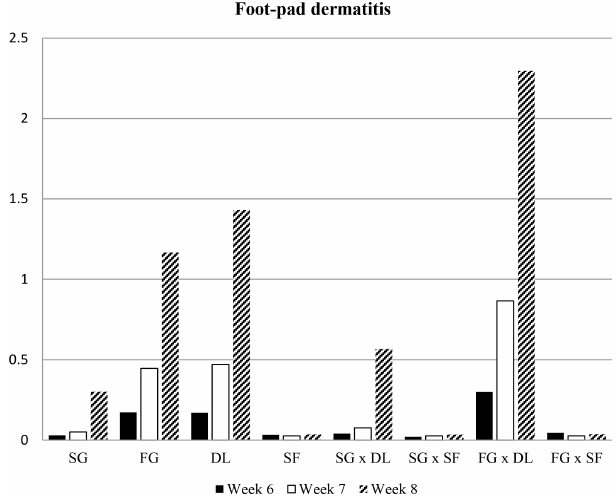
Figure 1. Mean value of foot-pad dermatitis scores of all groups. SG: slow growing, FG: fast growing, DL: deep litter, SF: slatted floor.